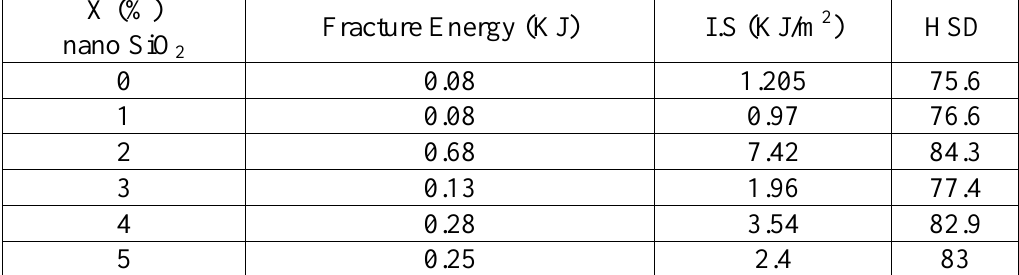
Fig.16: Hardness shore D with filler for all samples. Table 4: Fracture energy (KJ), Impact strength (KJ/m 2 ) and Hardness shore D for composites (unsaturated polyester resin with filler (silica